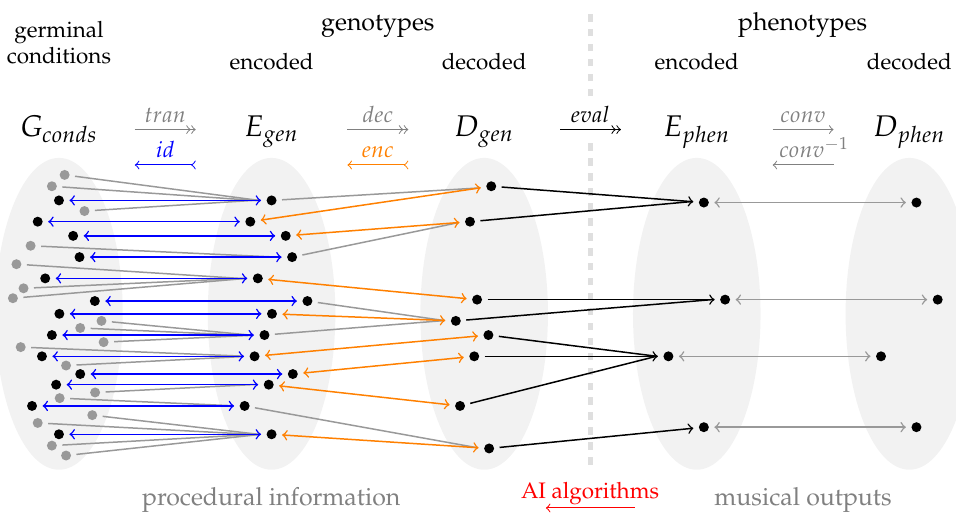
Figure 1. Mappings from germinal conditions to musical outputs. Double-ended blue arrows illustrate the retrotranscription feature of the tran conversion: any encoded genotype vector (cid:126) y ∈ E gen belongs to the germinal vectors set G conds as well, as it autogenerates itself. Orange arrows show how the encoding of a decoded genotype ∈ D gen generates a unique numerical representation, although different encoded genotypes may correspond to the same decoded expression, due to the readjustment of parameters needed to fit into valid